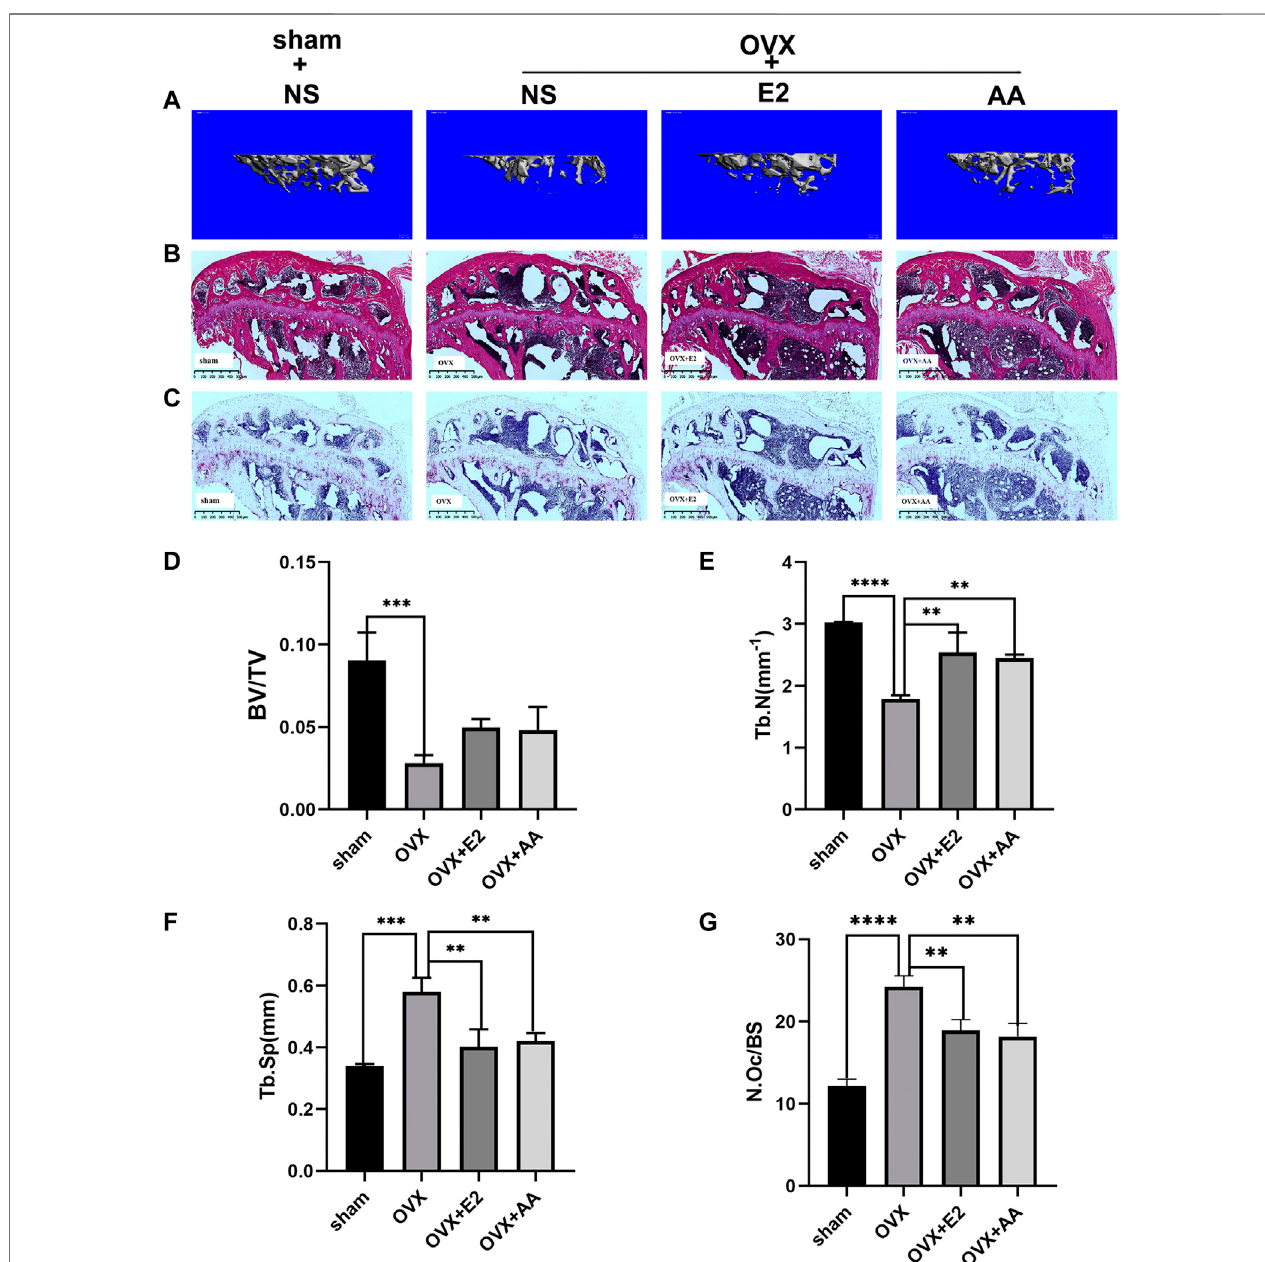
FIGURE 5 | Asiatic acid suppresses the progression of osteoporosis in ovariectomized mice. (A) Three-dimensional reconstructed representative image of the mouse tibia. (B) Representative images of HE-stained tibia in mice. (C) Representative images of Trap staining of mice tibia. (D – F) Quantitative analysis of bone volume/ tissue volume (BV/TV), bone trabecular number (TB. N), and bone trabecular separation (TB. SP) of mice ( n = 3). (G) Quantitative histological analysis of TRAP-positive cell percentage per bone surface in each group ( n = 3). All values are presented as the mean ± SD ( n = 3). * p < .05; ** p < .01; *** p < .001; **** p < .0001.